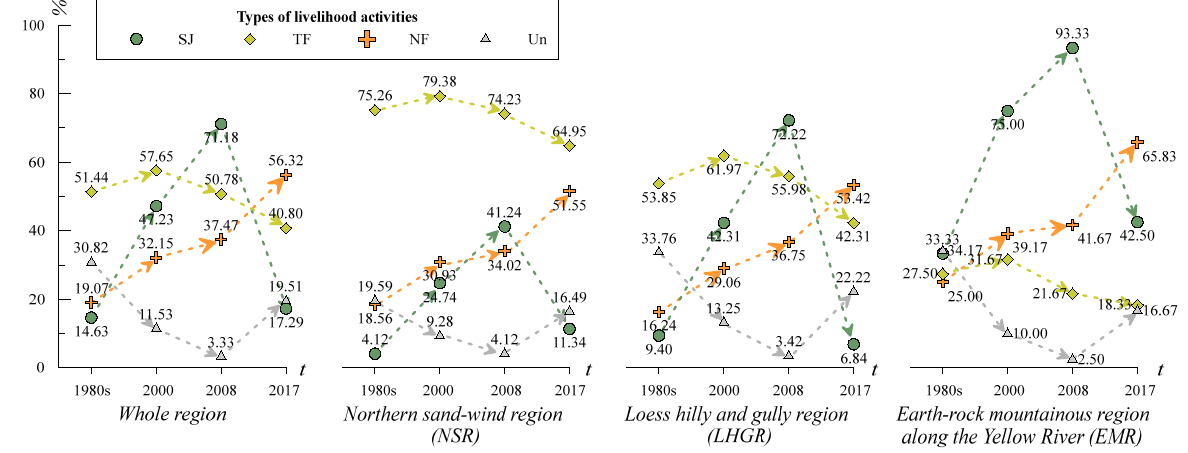
Figure 3. Trajectory of the share of households participating in livelihood activities in different re- gions.